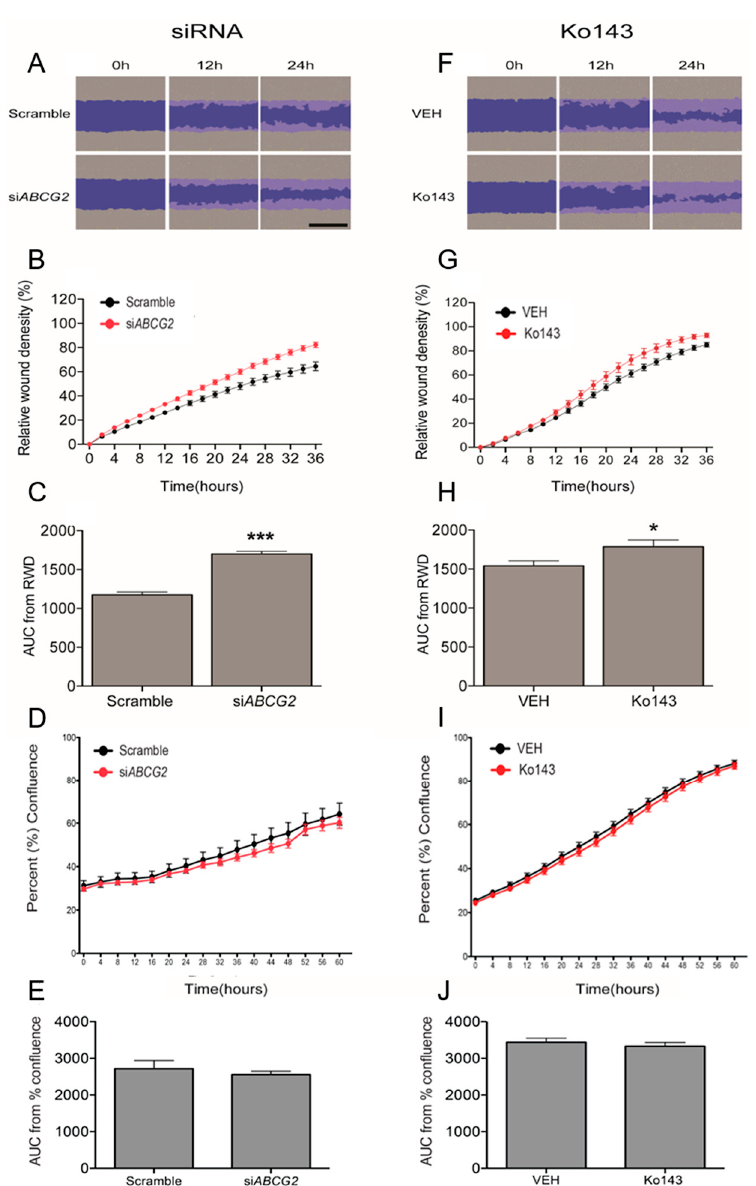
Figure 3. Inhibition of BCRP using siRNA or BCRP specific inhibitor Ko143 increases migration of human EVTs without a ff ecting cell proliferation. HTR8 / Svneo cells were cultured in a monolayer in 96-well plates and a wound was made across the diameter of wells using a 96 well Wound Maker. ( A – C ) Cells were transfected with 50 nM si ABCG2 or its scrambled sequence for 48 h prior to wounding and then imaged every 2 h for 36 h to determine relative wound density. ( F – H ) Cells were washed, pre-treated with Ko143 or its vehicle (VEH) for 2 h and imaged with IncuCyte ™ every 2 h for 36 h to determine relative wound density. ( B , G ) Quantification of relative wound density over the period of 36 h. ( C , H ) Comparison between treatments is shown by Area under curve analysis of the replicates. Data are expressed as means ± SEM, n = 6 per group. Statistical di ff erences were tested by unpaired t test. * p < 0.05 versus VEH, *** p < 0.001 versus VEH. Scale bars = 600 µ m. ( D , E , I , J ) cells were transfected with 50 nM of si ABCG 2 or scramble control for 24 h and time lapse imaging was performed by IncuCyte TM every 4 h for 60 h. ( D , I ) Percent confluence was quantified by incuCyte software and the graph shows mean of n = 6. ( E , J ) Comparison between treatments is shown by Area under curve analysis of replicates. Statistical di ff erences were tested by unpaired t-test. No di ff erences were found between the treatments versus the vehicle control.